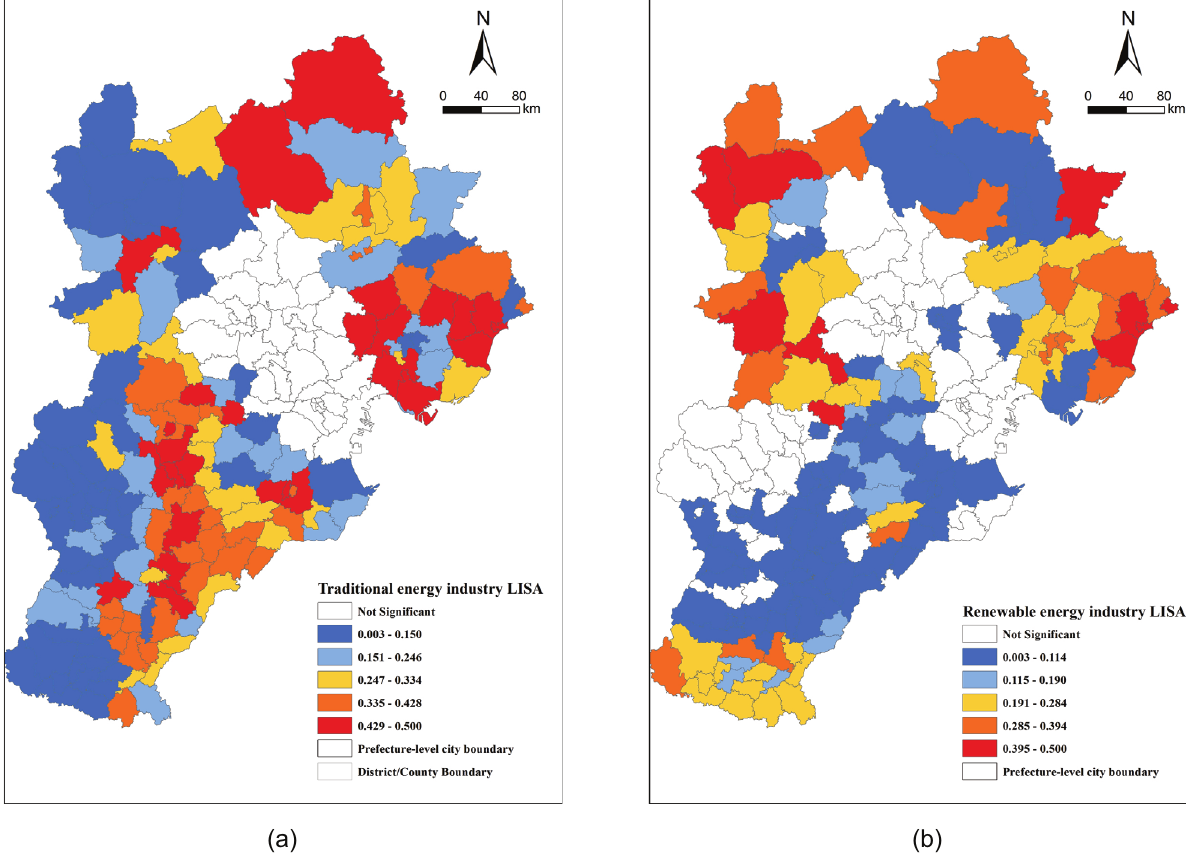
Fig. 1. LISA map of the energy industry in Hebei province in 2021. (a) Traditional energy industry. (b) Renewable energy